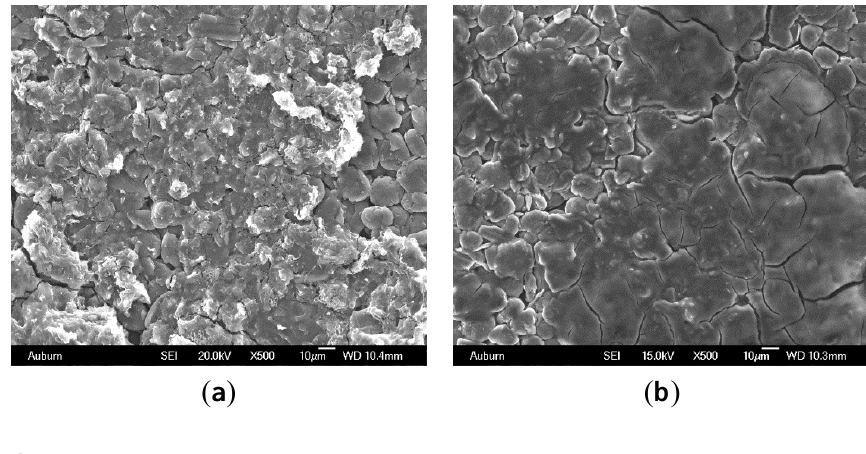
decomposition. ( a ) Surface film agglomerates; ( b ) Surface film forms a “mat” on